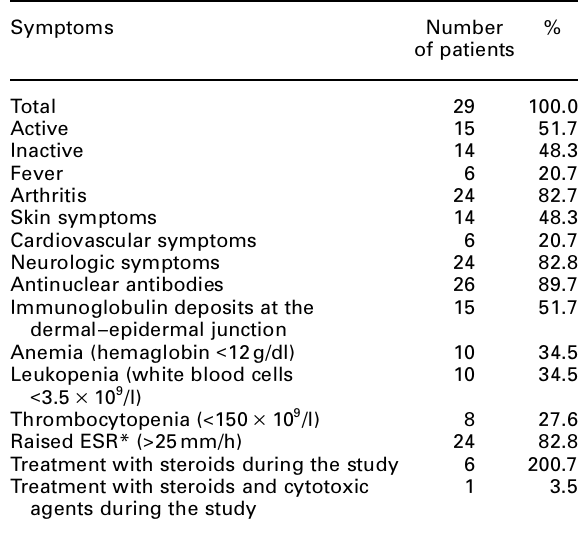
Table 1. Clinical and laboratory characteristics of the patients with